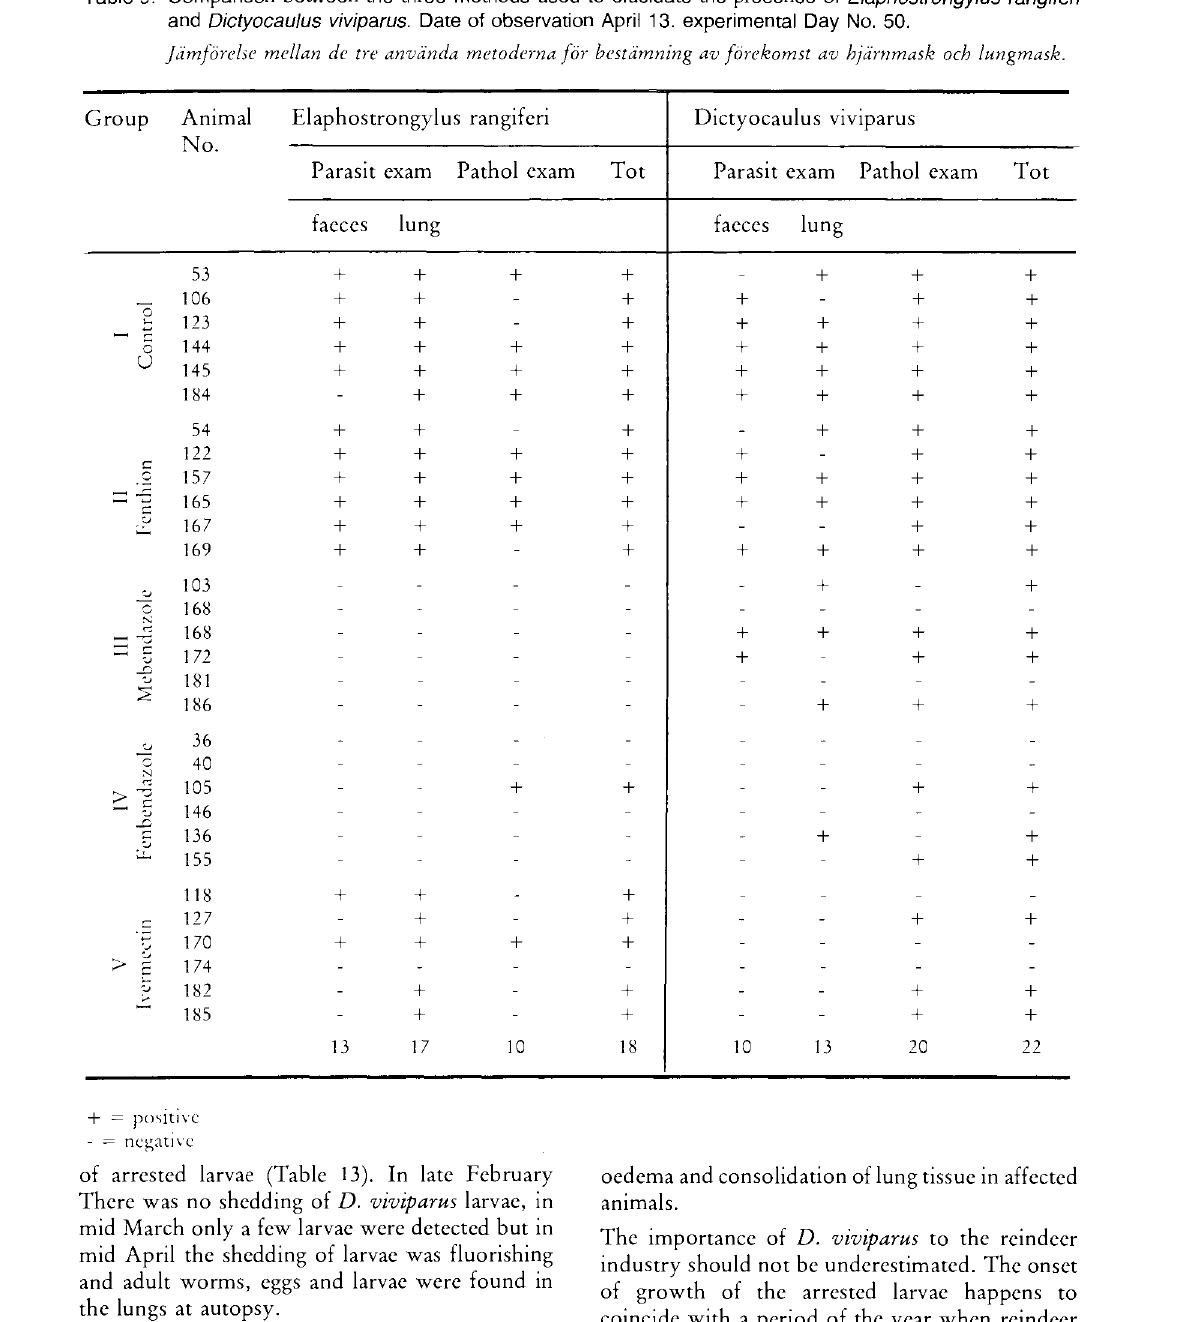
Table 9. Comparison between the three methods used to elucidate the presence of